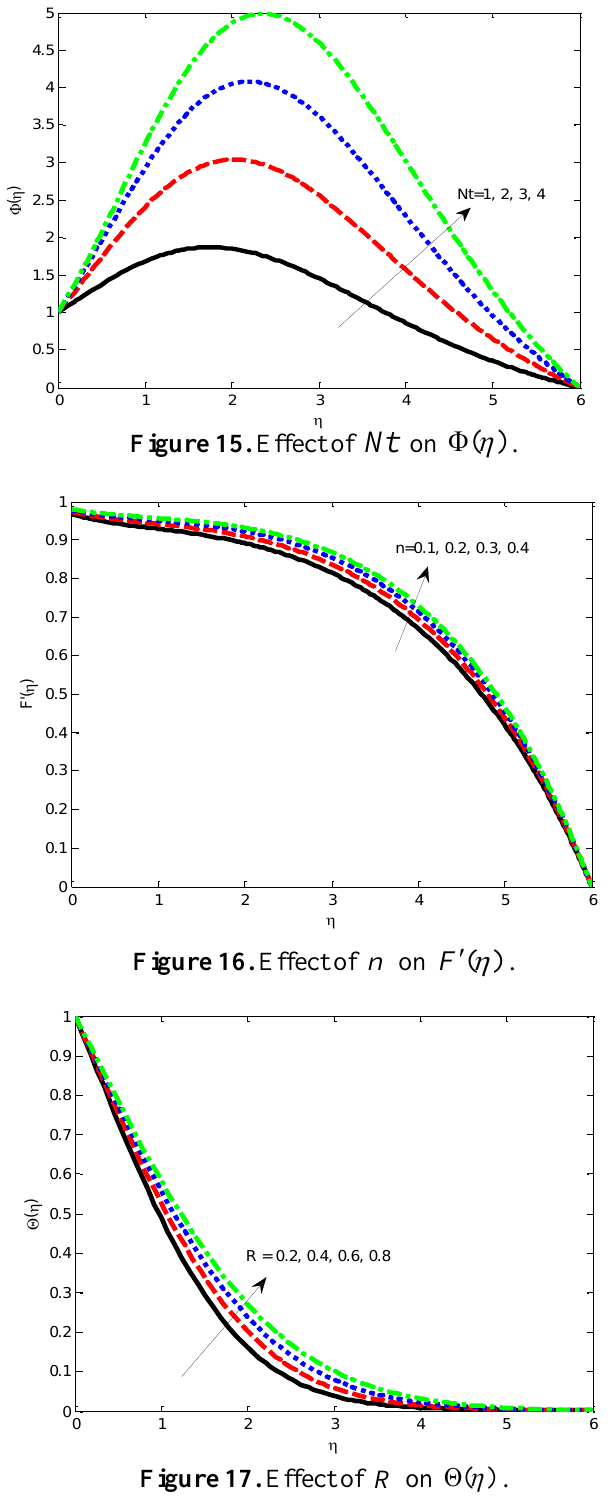
Figure 17. Effect of R on ( )  . on temperature profiles. The